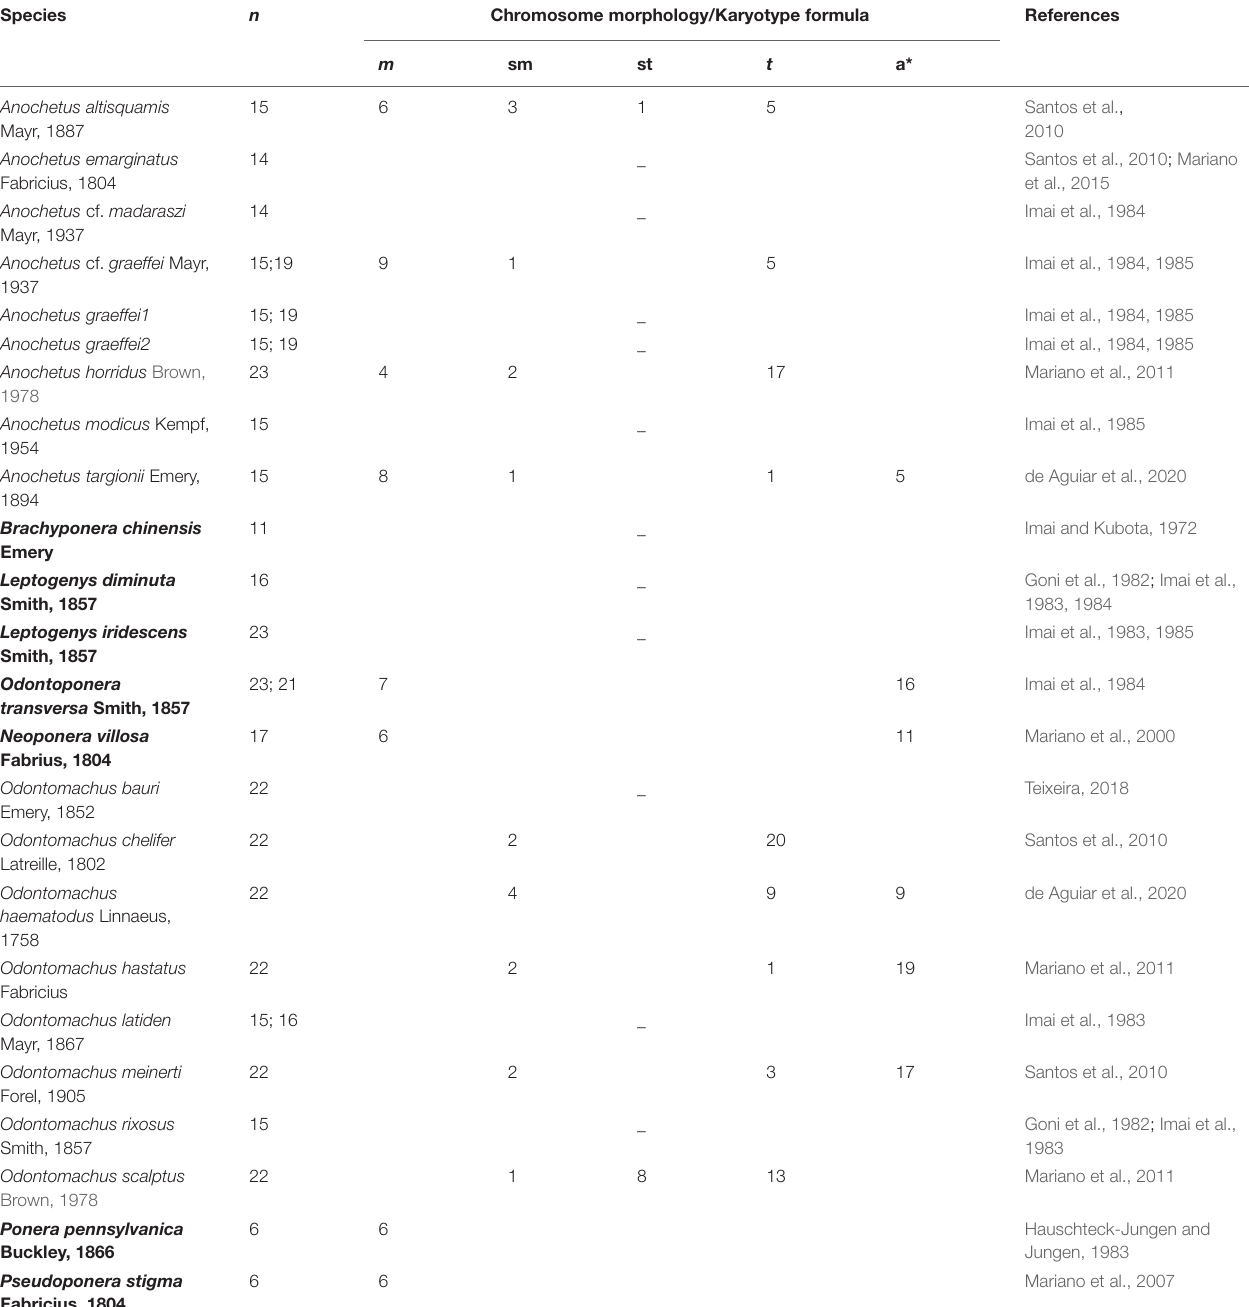
TABLE 1 | Chromosome haploid numbers and karyotype formula for Anochetus and Odontomachus species found in the literature plus outgroups used in reconstruction analysis (in bold). Species n Chromosome morphology/Karyotype formula